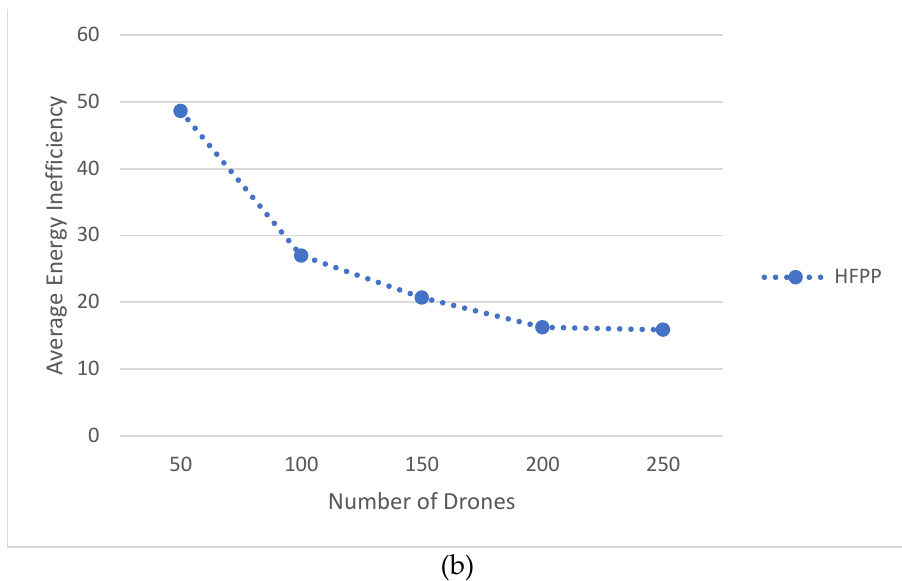
Figure 5. ( a ) Average consignment delivery delay, and ( b ) average energy inefficiency, of HFPP when number of drones varies.